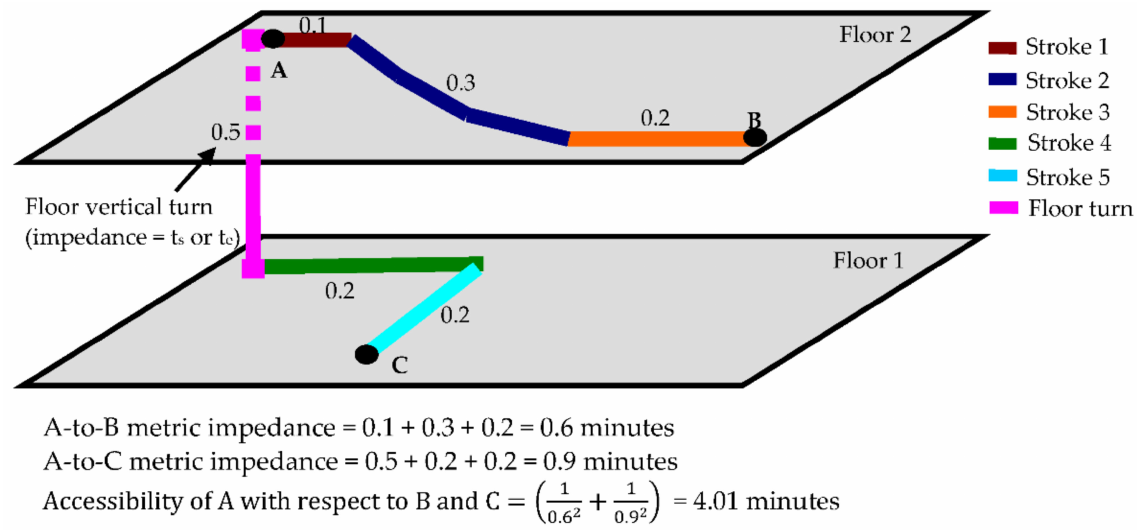
Figure 8. Metric impedance (minutes) of traveling paths and accessibility estimation with α = 2.